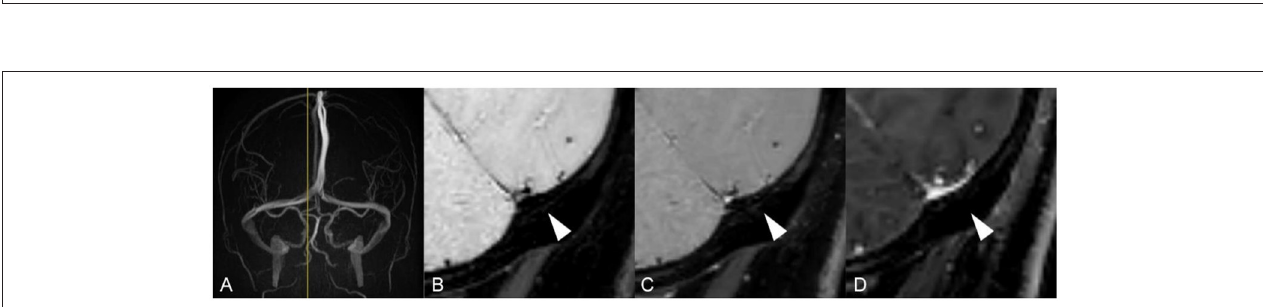
FIGURE 5 | Images reveal a stenosis in 29-year-old man with intracranial hypertension symptom. (A) MRV shows normal venous sinus; (B–D) T1w black-blood image, T1w black-blood contrast-enhanced image and T1w contrast-enhanced image show thin cava vascular lumen.